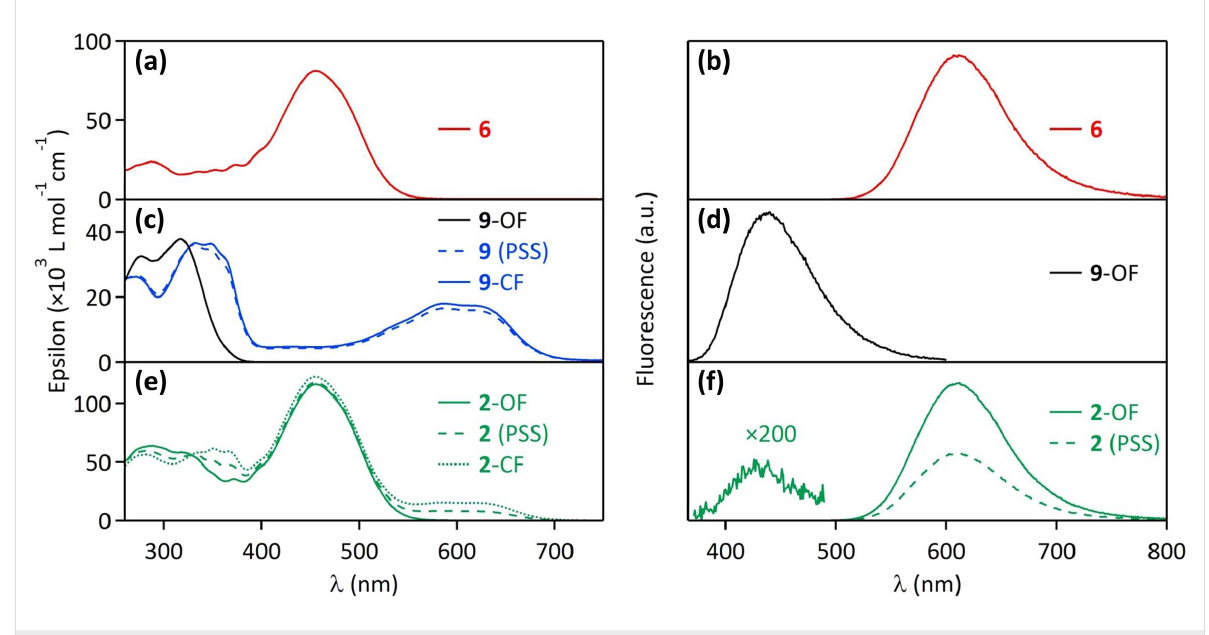
Figure 3: Absorption and fluorescence spectra of compounds 6 , 9 , and 2 in CH 3 CN: (a) absorption spectrum of 6 ; (b) emission spectrum of 6 ( λ exc = 450 nm); (c) absorption spectra of 9 -OF, 9 at the photostationary state (PSS) under 335 nm illumination, isolated 9 -CF; (d) emission spectrum of 9 -OF ( λ exc = 325 nm); (e) absorption spectra of 2 -OF, 2 at the photostationary state (PSS) under 335 nm illumination (no noticeable change